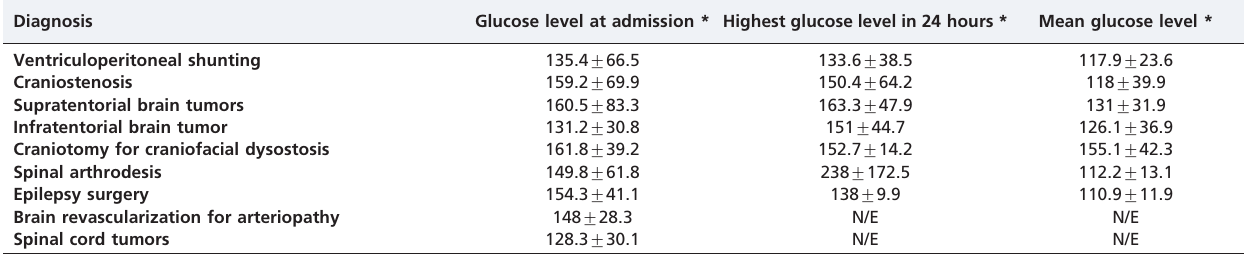
Table 1 - Glucose levels according to surgical diagnosis.